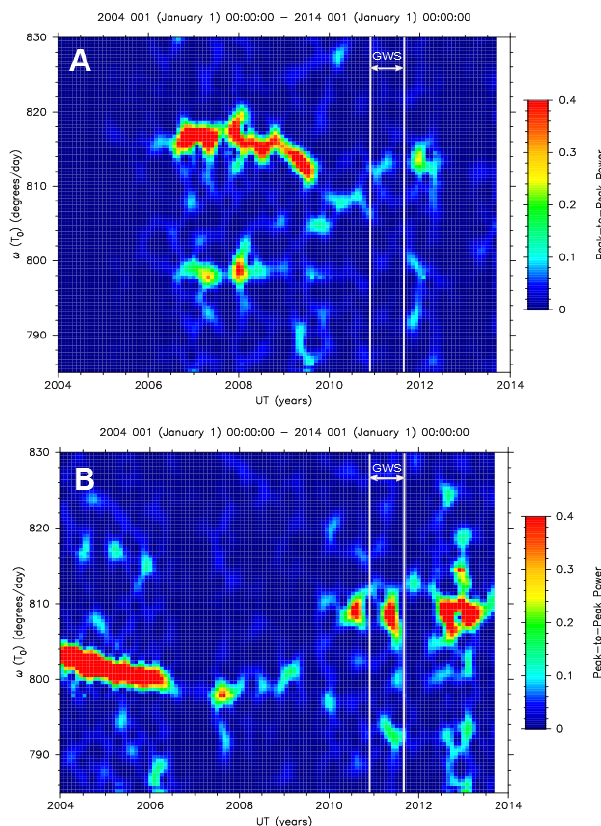
Figure 3. Normalized peak-to-peak power of northern and southern SKR modulation as a function of time from 2004 until mid-2013. The upper panel (a) shows the periodogram for the northern SKR and the lower panel (b) for the southern SKR. The display is similar to Fig. 1, and the vertical white lines indicate the start and end of the GWS